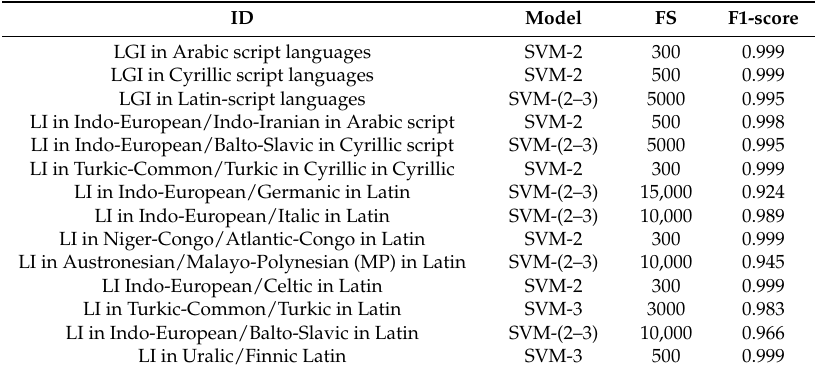
Table 20. Selected OCM for LGI and LI in LG in three-stage LI-2.